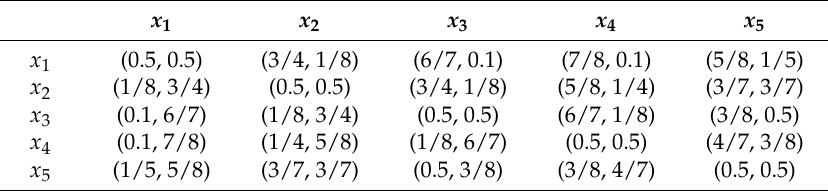
(cid:16) = ( ξ ij ( 3 ) , η ij ( 3 ) 5 × 5